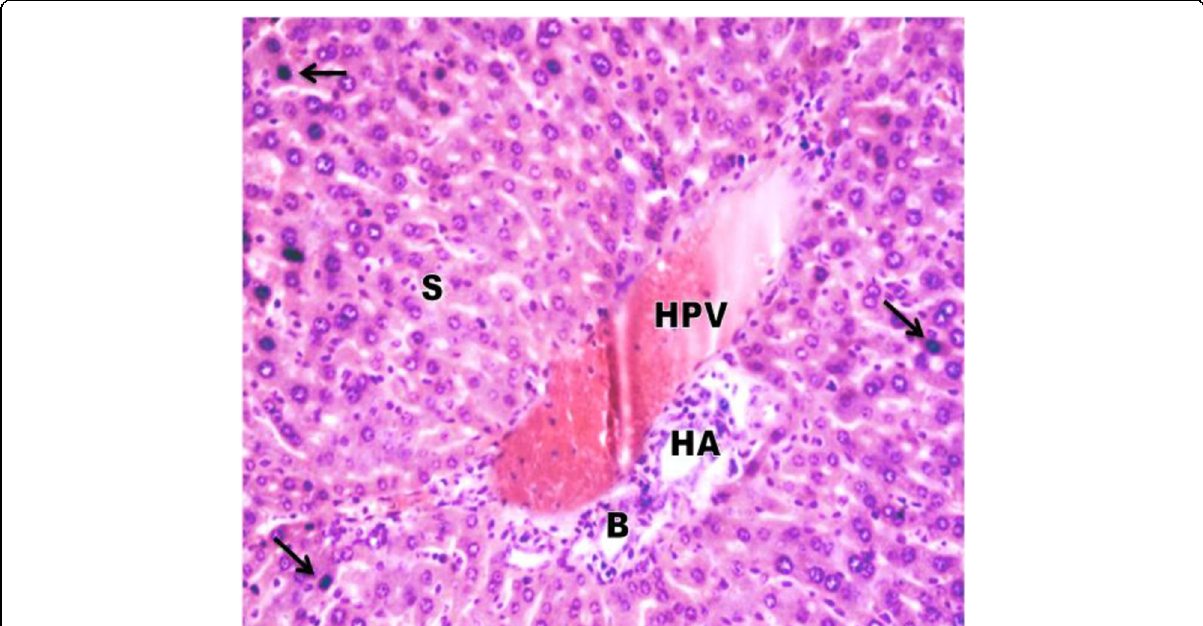
Fig. 10 Photomicrograph of a section of the liver of treated mouse with Tamiflu (16 mg/kg b.wt.) in addition to Adamine (20 mg/kg b.wt.) for 10 days revealing hepatocytes with pyknotic nuclei (arrows), enlargement, and congestion in hepatic portal vein (HPV) and dilatation of hepatic sinusoid (S). (H&E, × 400)